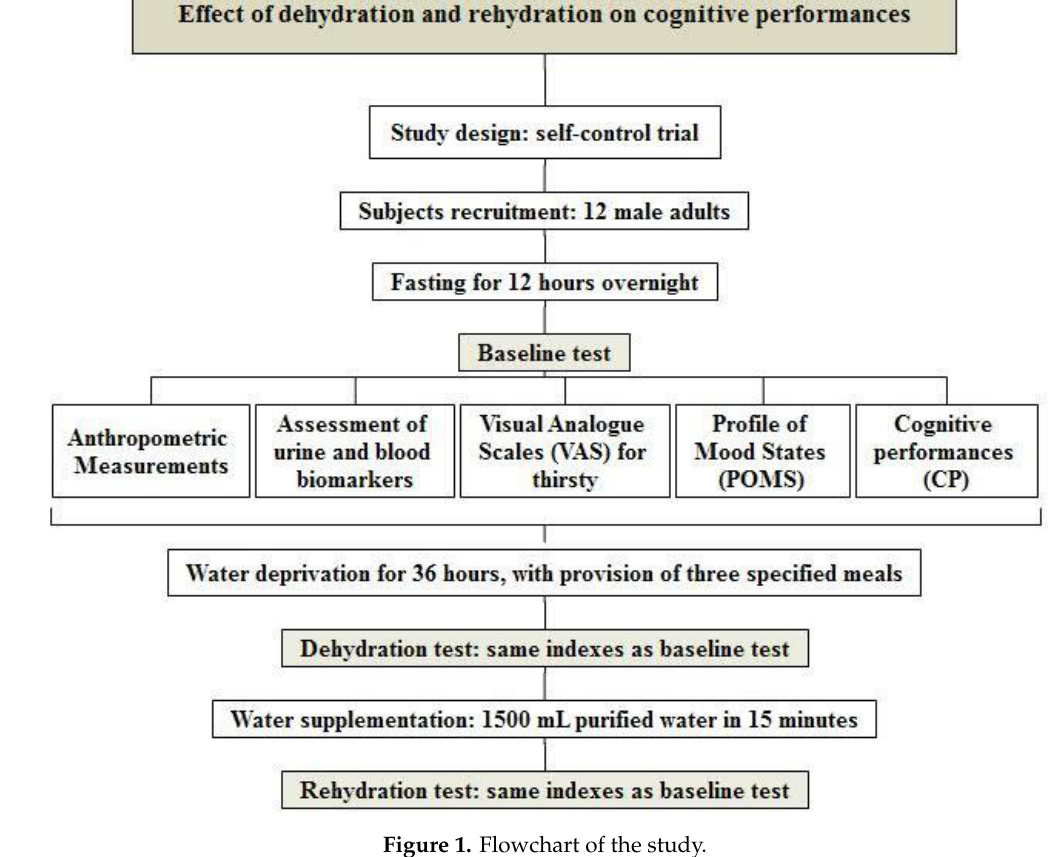
Figure 1. Flowchart of the study.